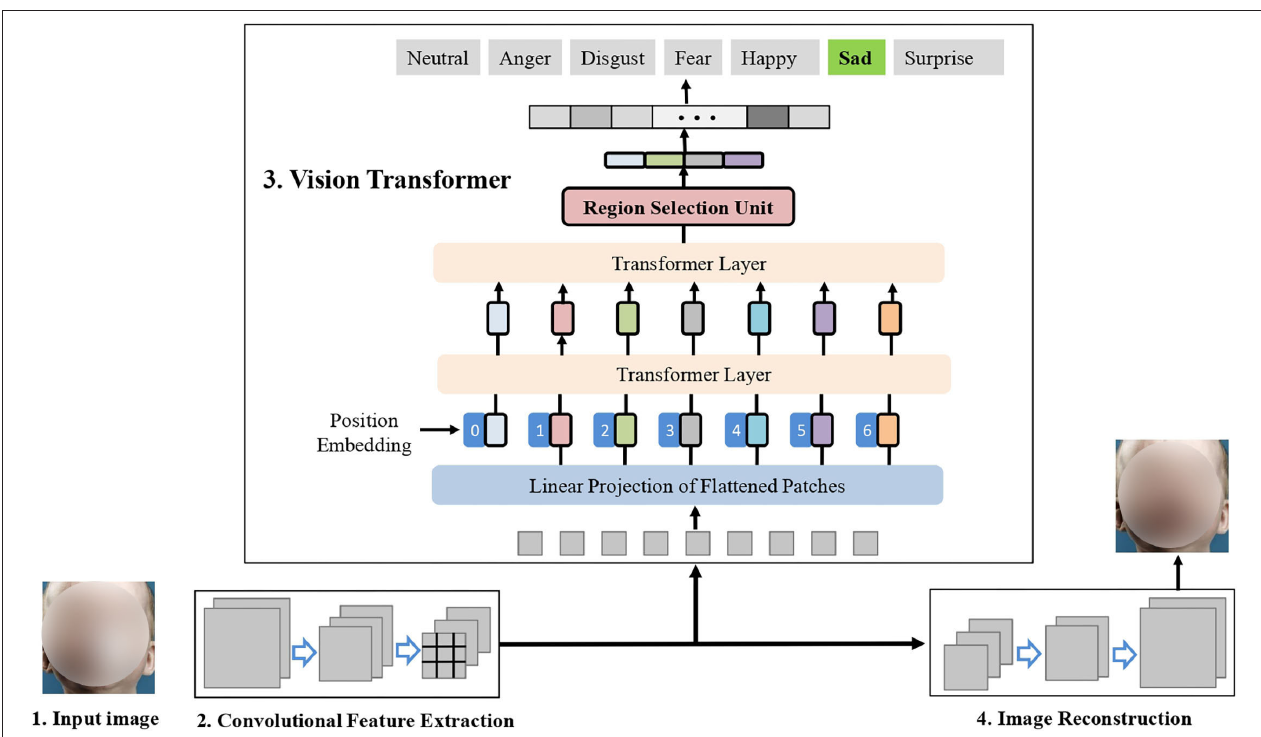
FIGURE 2 | Main idea of the proposed T ransformer Architecture for f acial e xpression recognition (TFE). TFE perceives the informative facial expression representation via the vision transformer and the proposed RS-Unit. In the right part, TFE uses an auxiliary decoder to reconstruct the unoccluded